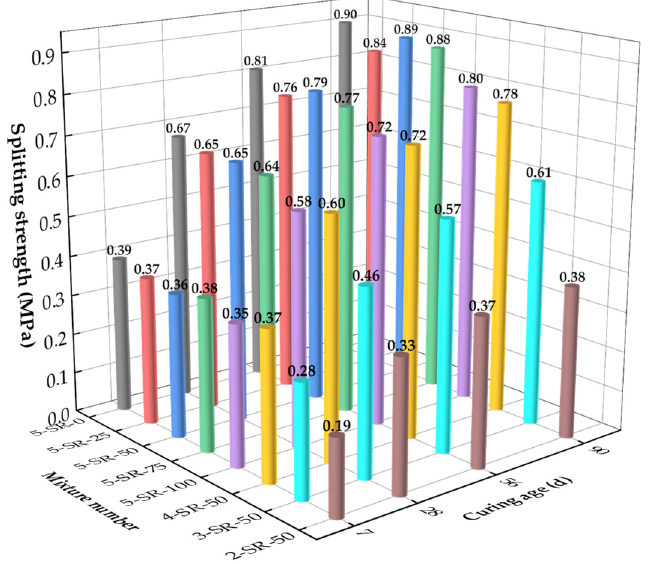
Figure 11. Results of splitting test with various